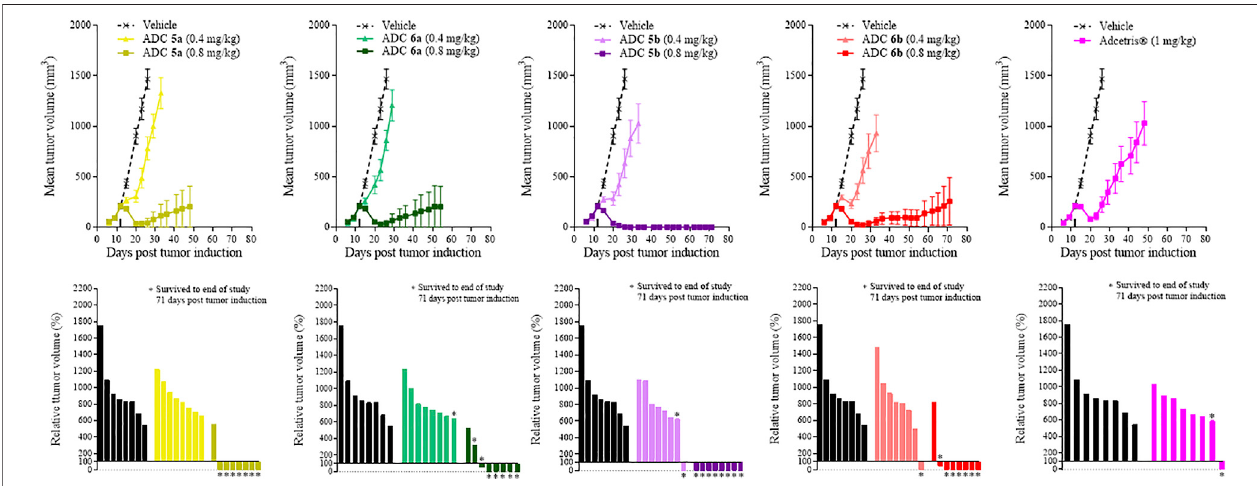
FIGURE 3 | Tumor growth curves and relative tumor volume (%) plots taken on the fi nal day of the study (Day 71) for xenograft study 2. Mean tumor volumes was plotted untilthe fi rst death inthe group wasrecorded. Relative tumor volumes were calculated as percentage change on the fi nal day ofthe study(Day 71) relative tothe tumor volumes on the day of treatment administration (Day